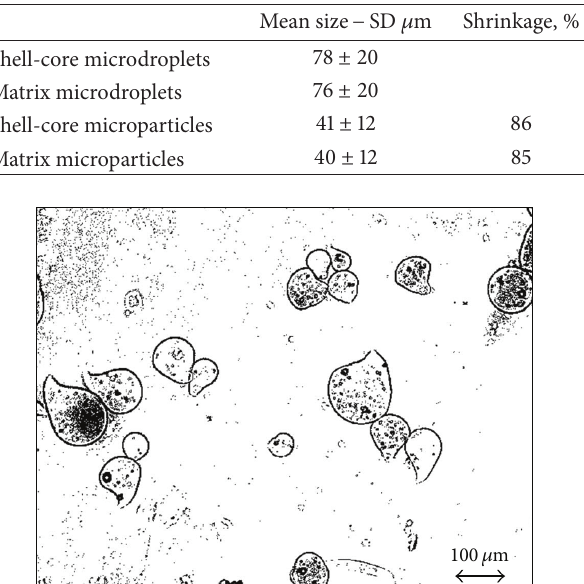
Table 2: Mean size and standard deviation for both shell-core and matrix microdroplets (fresh products) and microparticles (dried products) and volumetric shrinkage percentage for the dried ones.